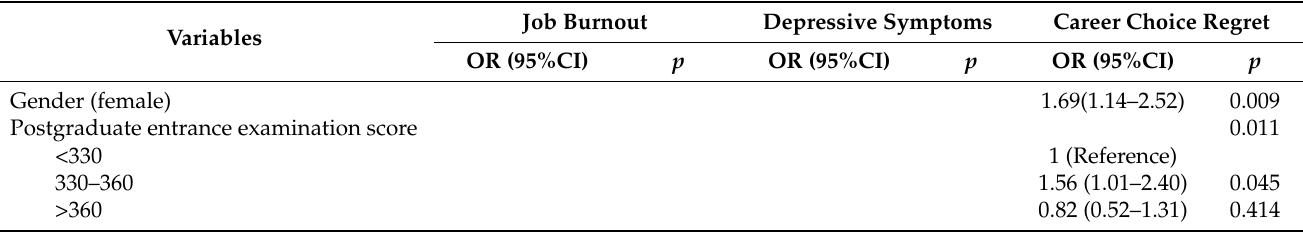
Table 5. Regression model two of job burnout, depressive symptoms, and career choice